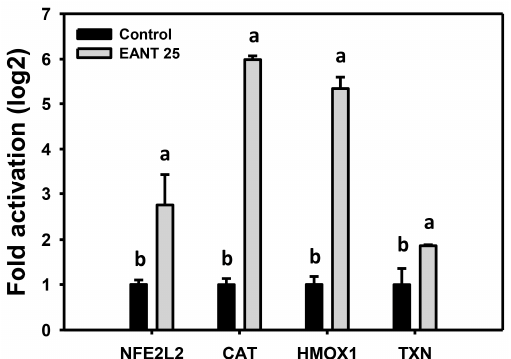
Figure 8. Antioxidant gene expression in EANT treated oral cancer cells. Cells were treated with EANT (control and 25 μg/mL (EANT 25) for 24 h), respectively. Several antioxidant genes were chosen for real-time RT-PCR analysis as indicated. Data (mean ± SD, n = 3) showing different letters on-top differ significantly for multiple comparisons ( p < 0.05).